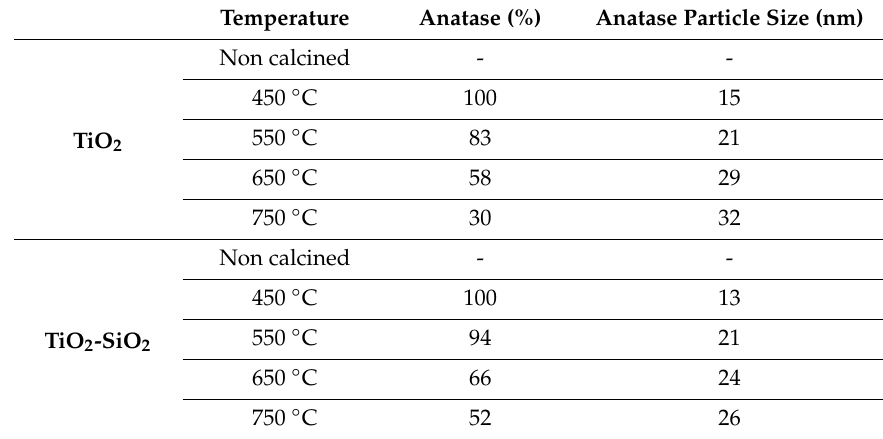
Table 1. Anatase percentage in crystalline TiO 2 (calculated by Spurr equation) and anatase particle size (calculated by Scherrer equation) for TiO 2 and TiO 2 / SiO 2 .